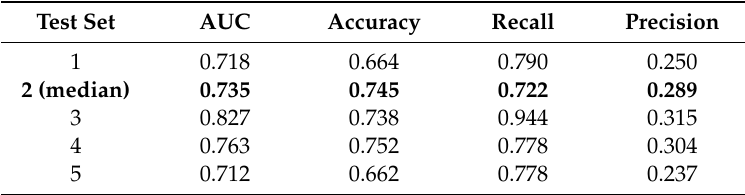
Table 3. Performance results in each of the 5-outer cross-validation test